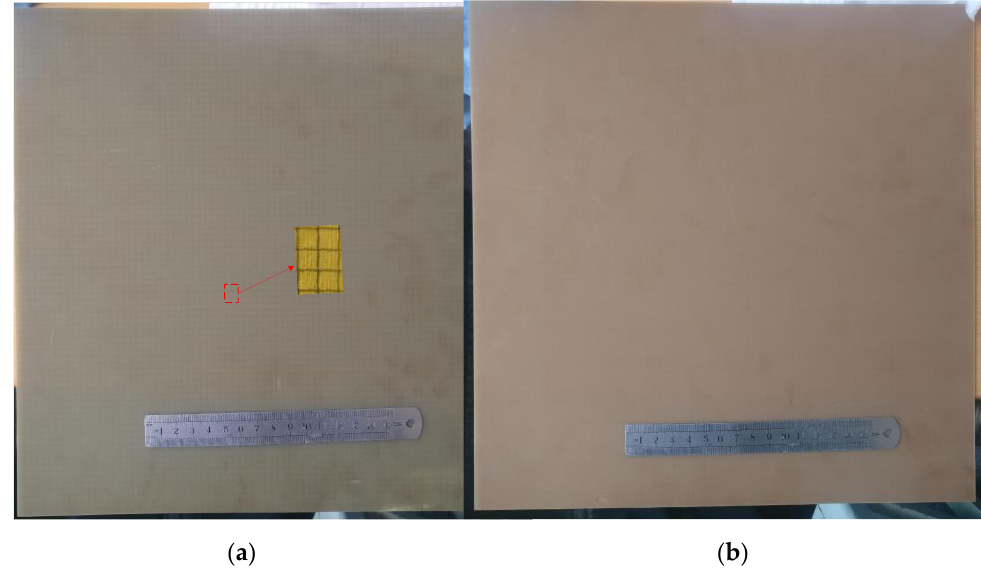
Figure 11. Fabricated prototype of the proposed FSS: ( a ) front view; ( b ) back view.